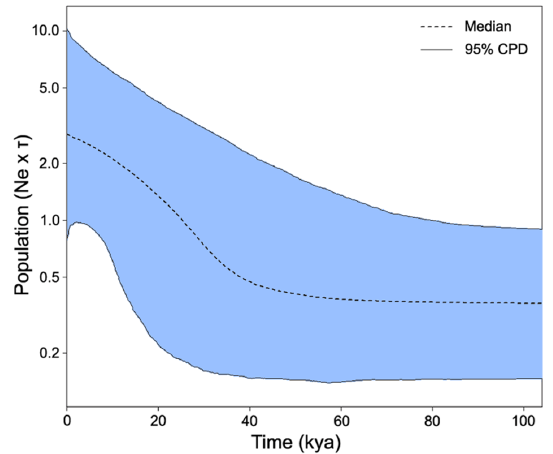
Figure 5. Time ‐ scaled extended Bayesian skyline plot (EBSP) with mtDNA and nDNA data for the giant anteater showing a population growth that started slowly ca. 60 ka ago and has largely in ‐ creased since ca. 40 ka ago. The dashed line represents the median estimate and the shaded area around it correspond to the 95% central posterior density